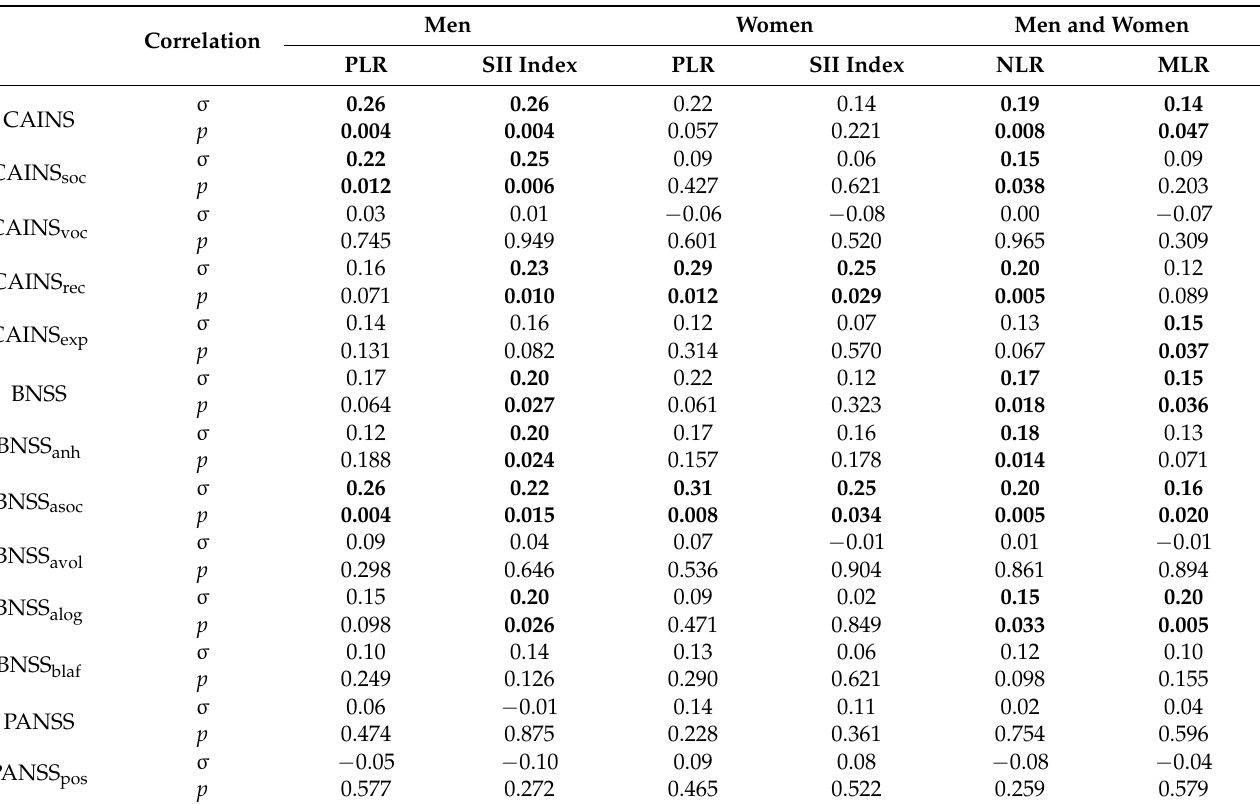
Table 6. Correlation of inflammatory ratios with the severity of positive and negative symptoms and total antipsychotic dose presented as chlorpromazine equivalents in patients with